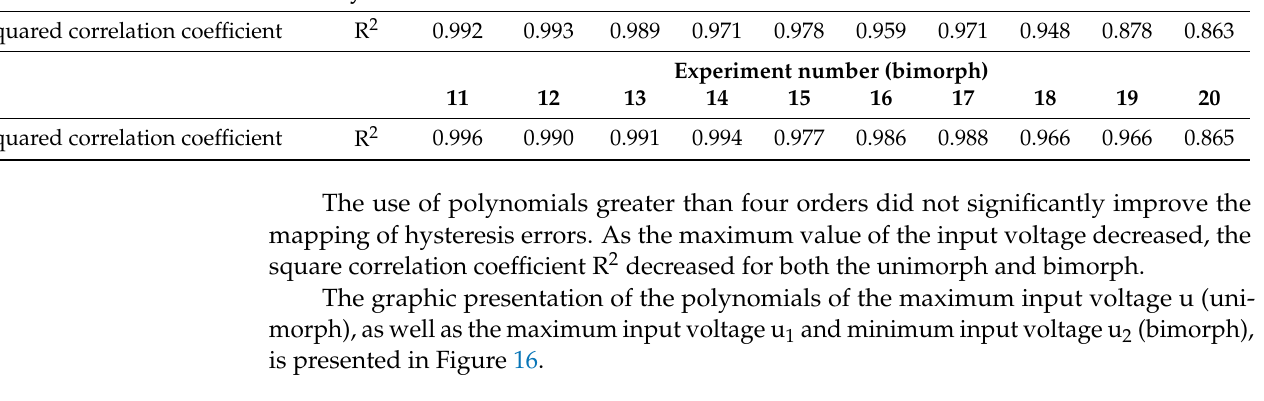
Table 6. Results of a regression